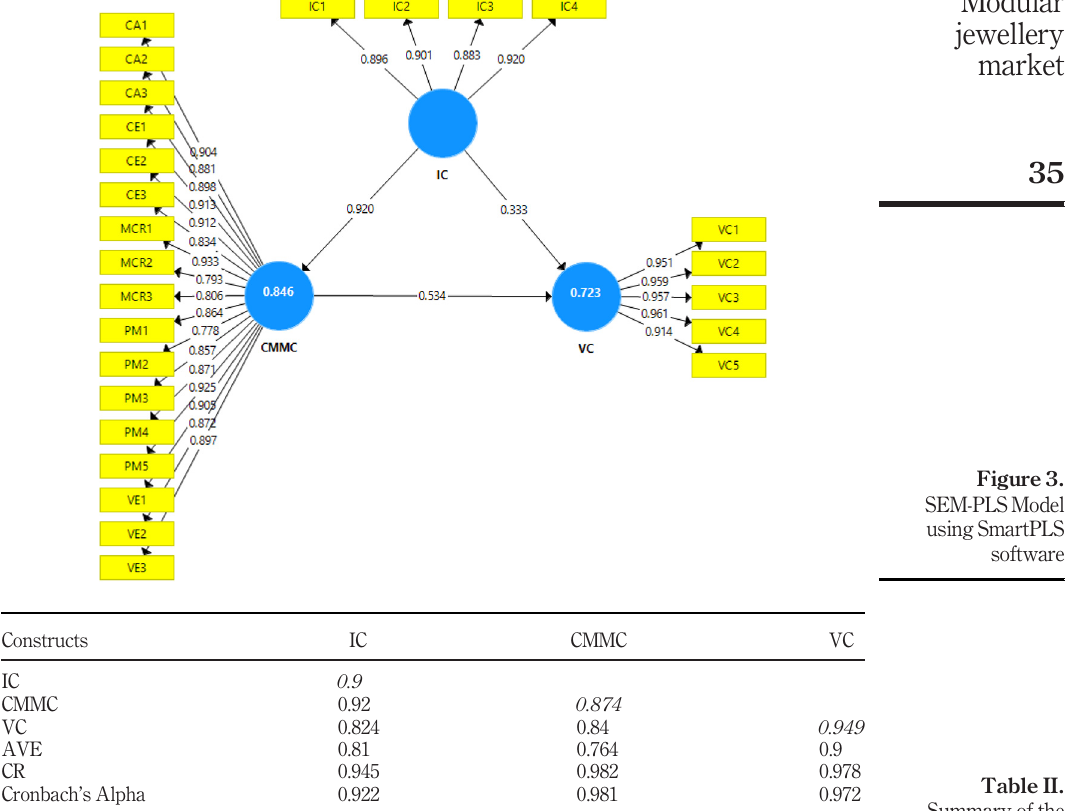
Figure 3. SEM-PLS Model using SmartPLS